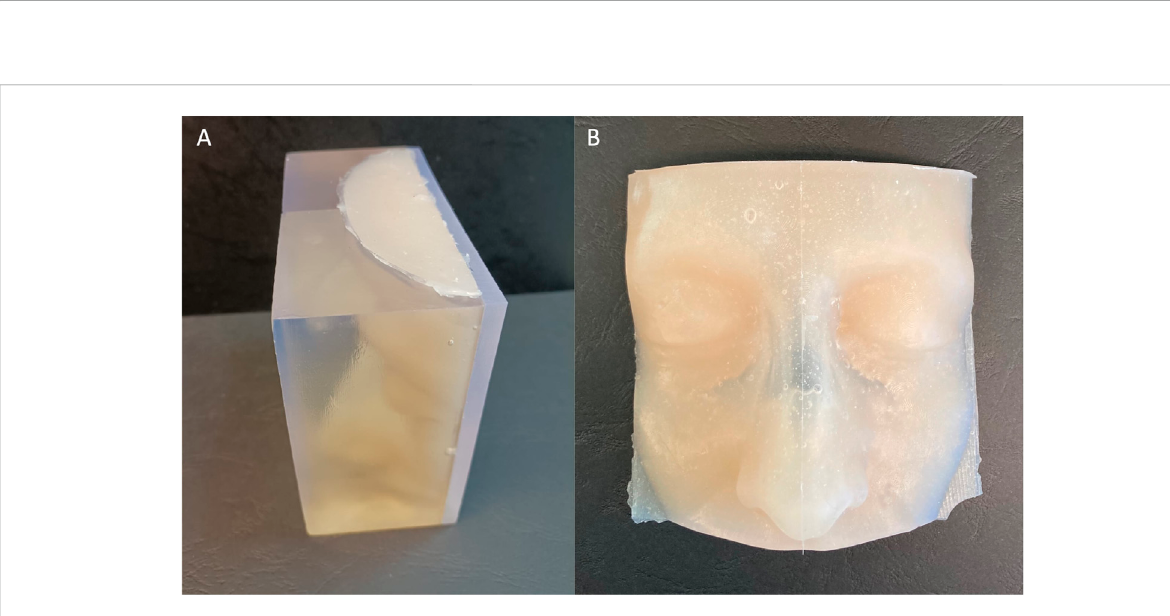
Frontiers in Bioengineering and